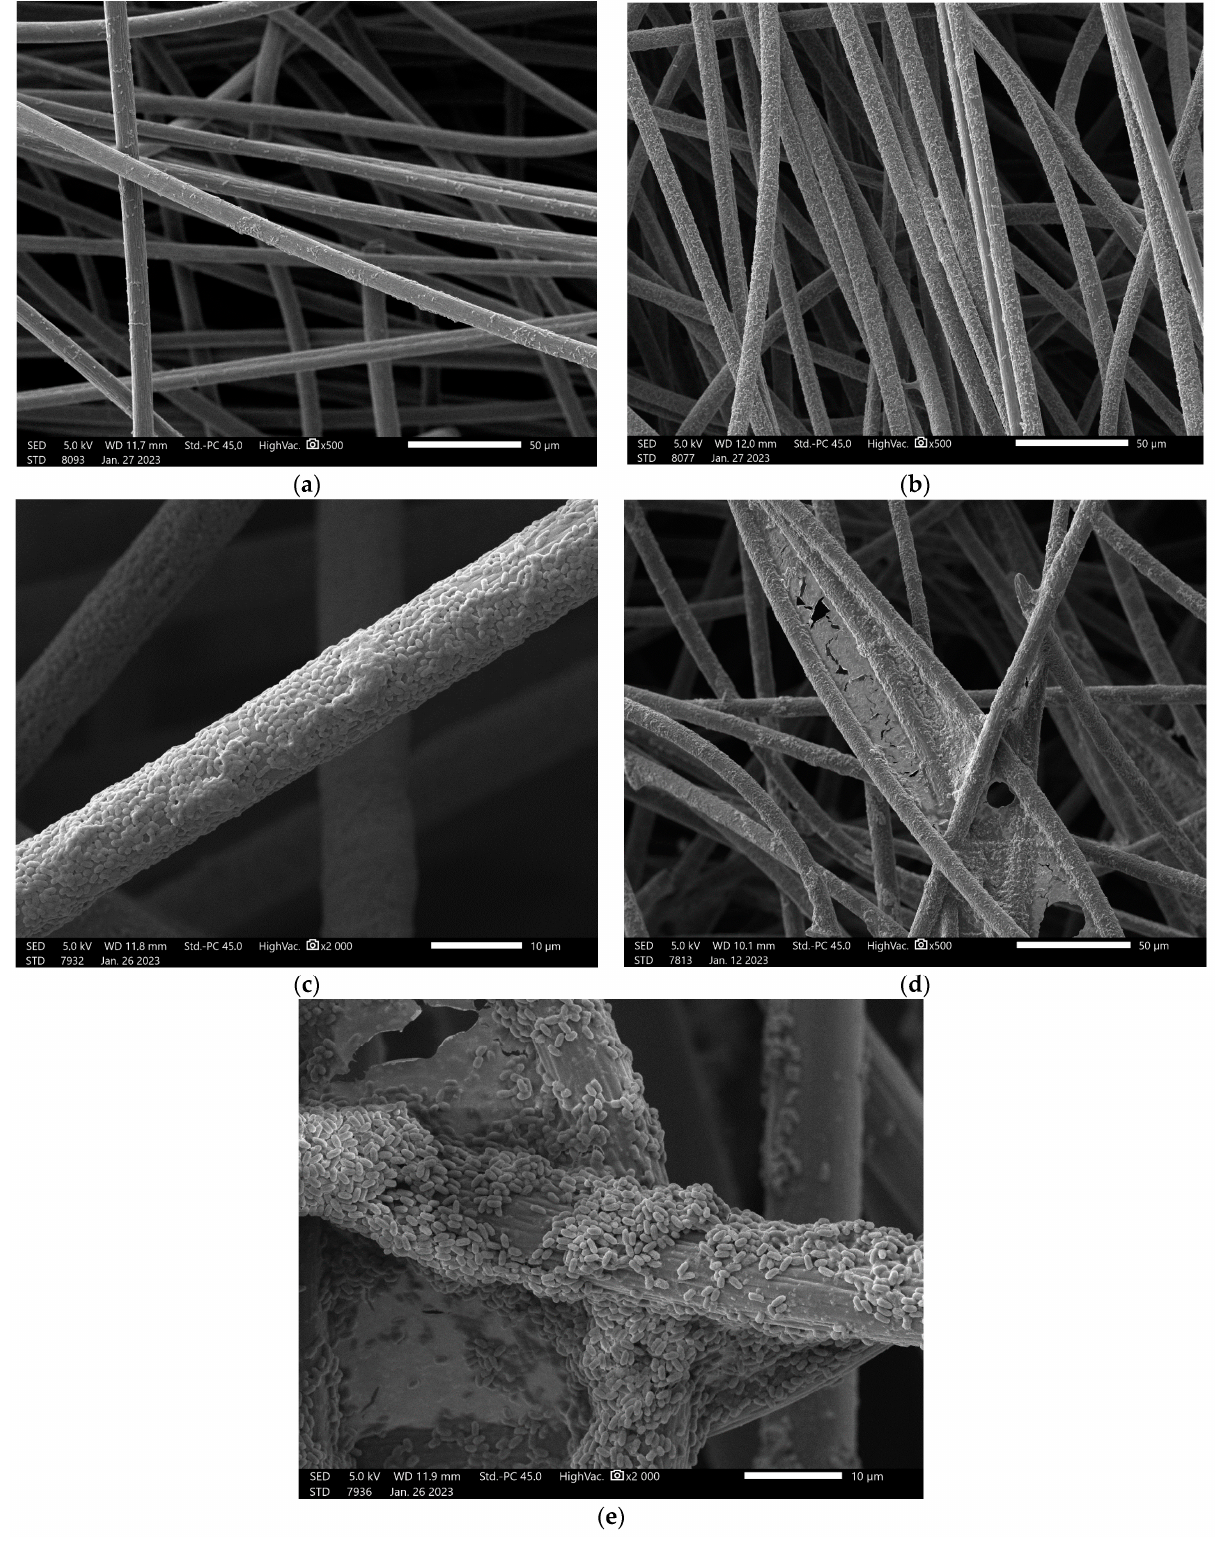
Figure 1. Stages of adhesion and biofilm formation observed on the surfaces of the carbon tissue fibres. ( a ) Presence of sporadic adhered bacteria (+); ( b ) Diffuse, but dense bacterial adhesion (++); ( c ) Confluent monolayer, with multilayer plaques (+++); ( d ) Multilayer biofilm; ( e ) Continuous biofilm also bridging the space between the adjacent fibres. Images of all isolates are summarized in Figure